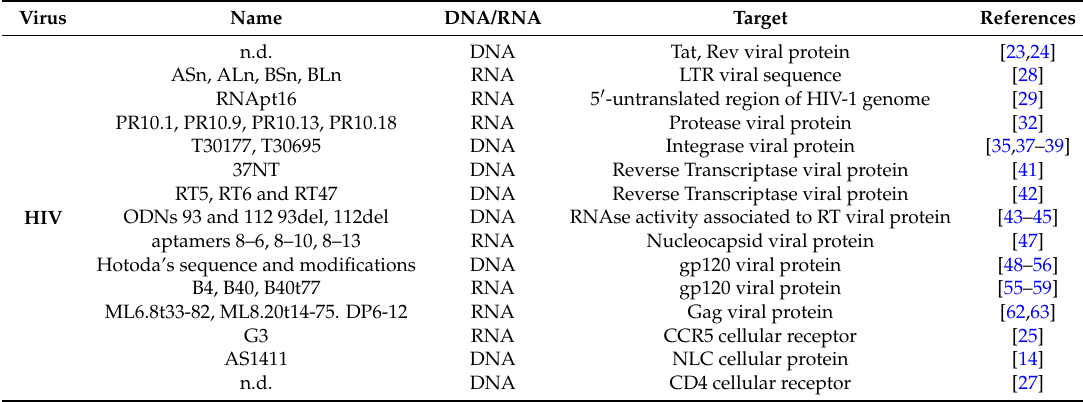
Table 2. Summary data on the aptamers selected against HIV discussed